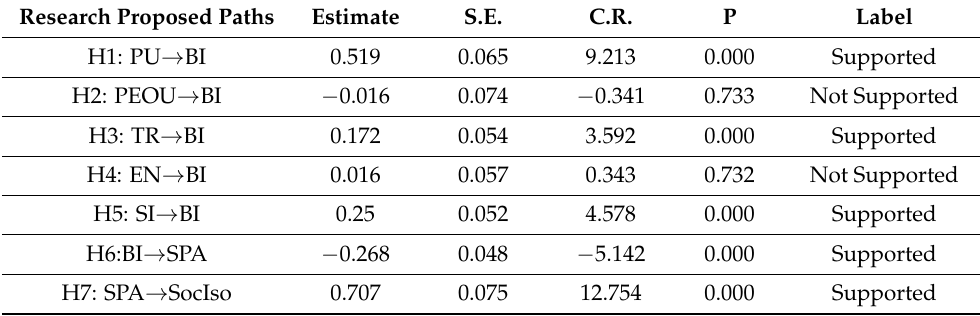
Figure 2. Model with coefficient estimates, R squared. Table 10. Summary of the results for the research theoretical